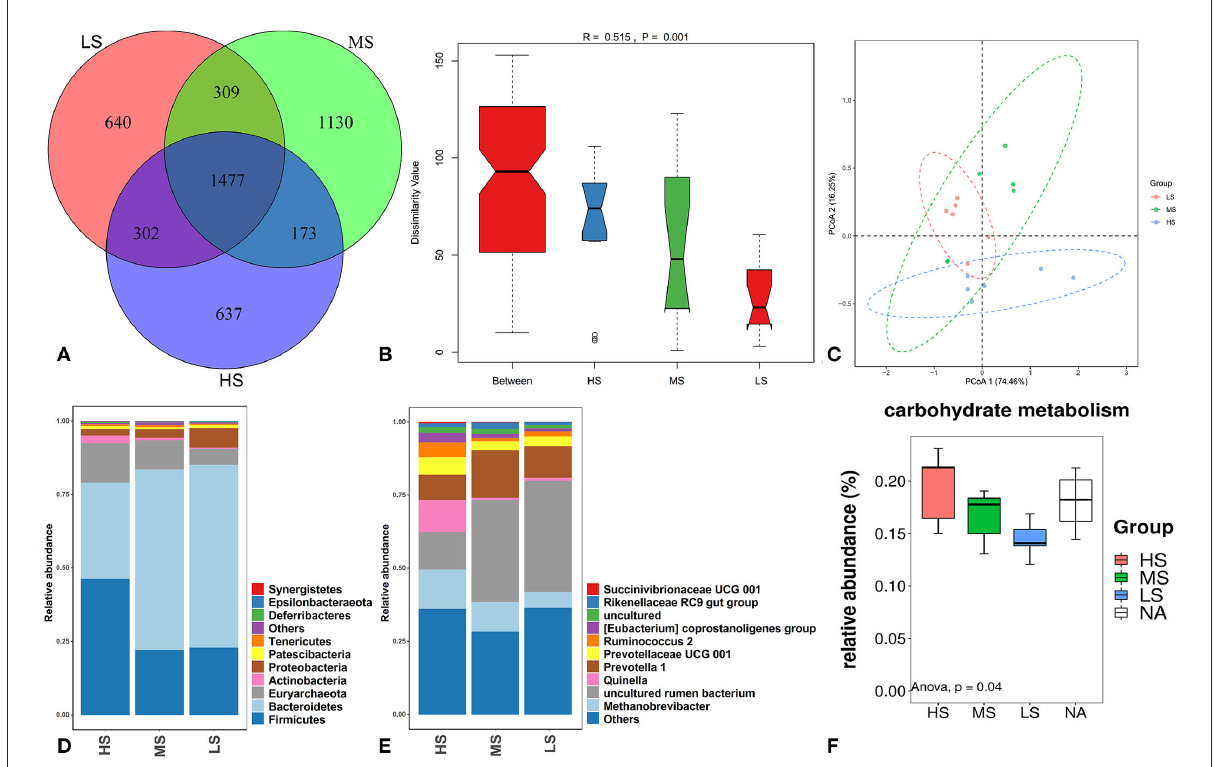
FIGURE5 OTUs Venn diagram of the overlap of rumen microbiota among the three groups (A) . Anosim analysis (B) and PCoA plot (C) of the overall samples of rumen microbiota. Relative abundance of bacteria community proportion at the phylum (D) and genus (E) levels among the three groups. Boxplot of the prediction of the most important diff rumen function (F)